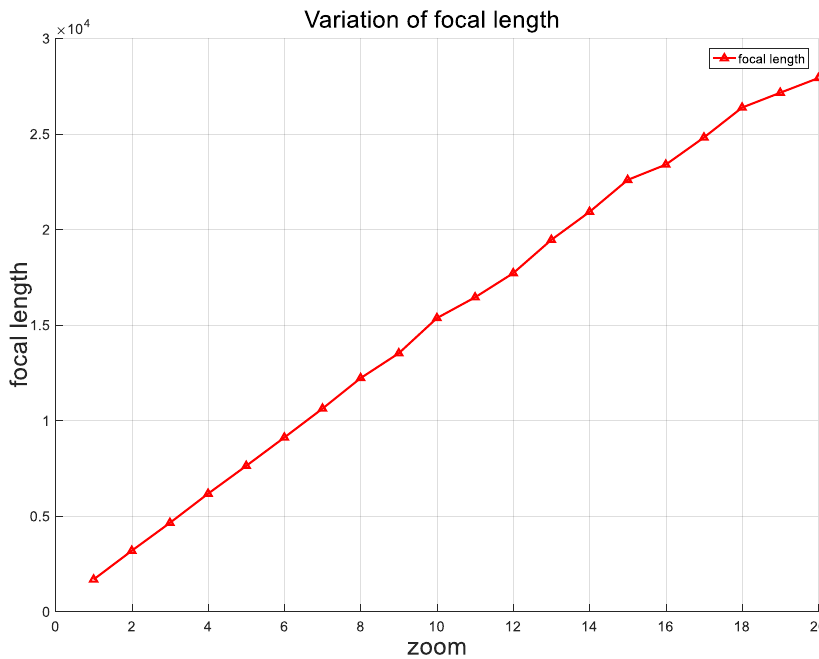
Figure 7. Variation of focal length with